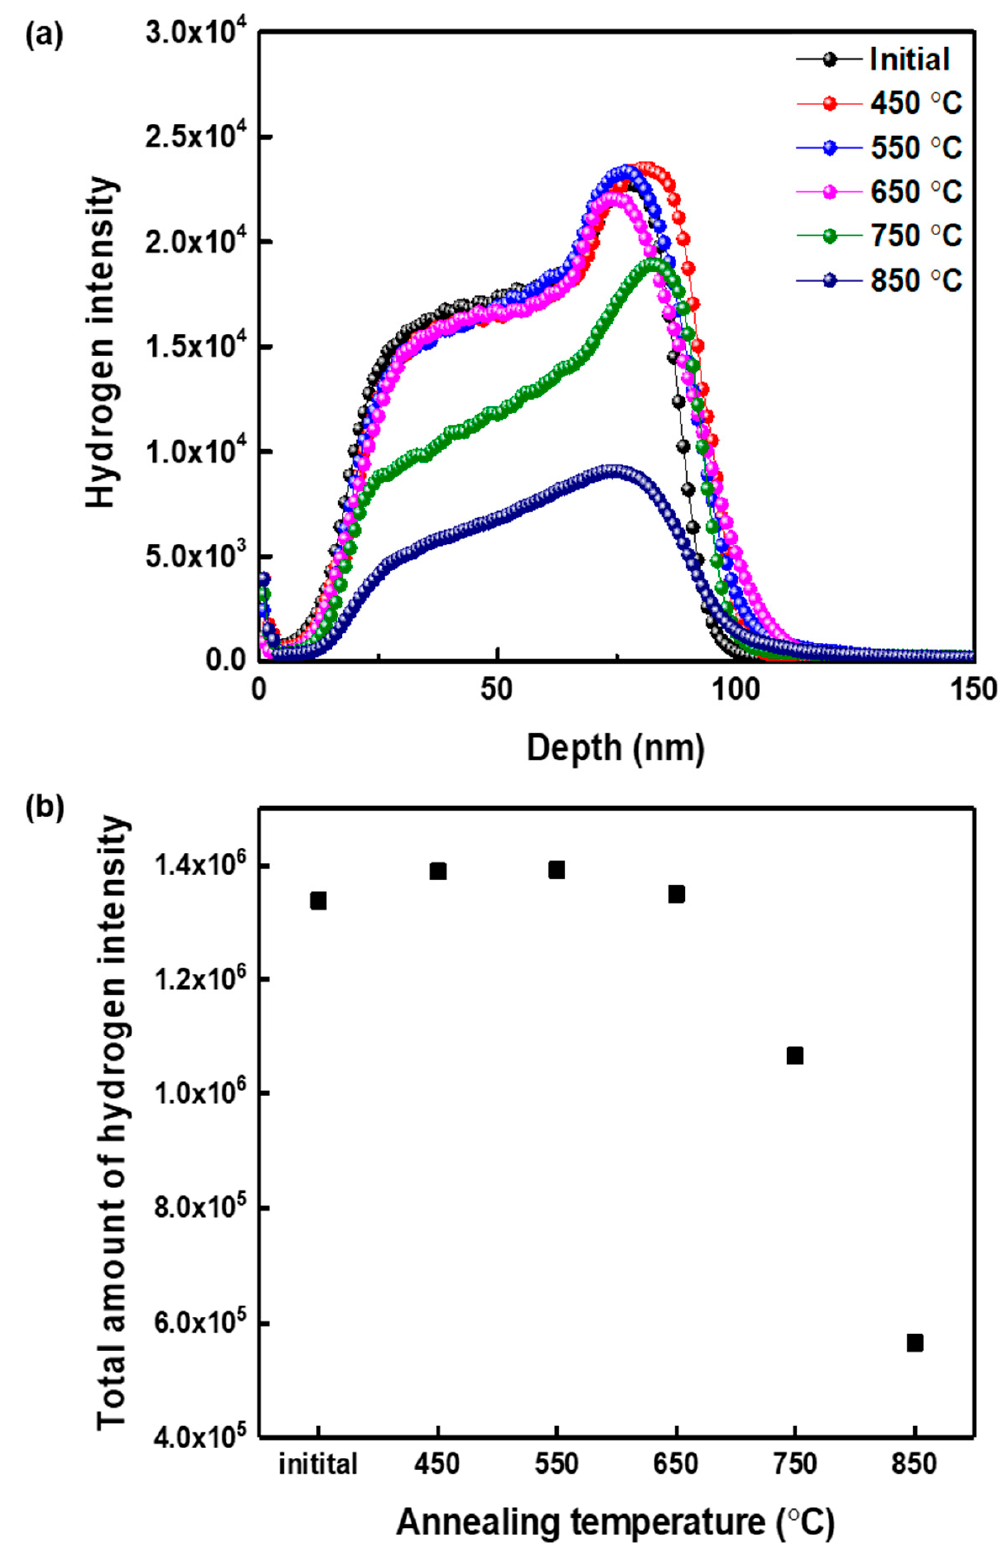
Figure 5. Hydrogen intensity in the samples at di ff erent annealing temperatures measured by time-of-flight secondary ion mass spectroscopy (ToF-SIMS) of the ( a ) hydrogen intensity, and ( b ) total amount of hydrogen intensity in the grain